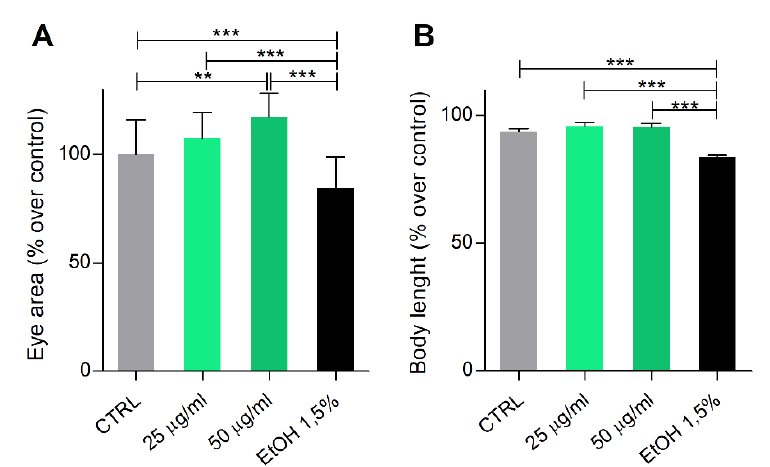
Figure 3. Phormidium EPS treatment has no toxic effects during zebrafish development. Zebrafish embryos were treated with EPS from 6 to 96 hpf, following the indication of the fish embryo acute toxicity test (FET) test. Graphs report results obtained with 25 and 50 µg/mL concentrations, relative to the positive effects on: ( A ) the eye’s area at 1 dpf and ( B ) total body length at 4 dpf. Data are shown as the mean ± SD. Statistical analysis was performed using GraphPad Prism 7 (one-way ANOVA followed by Tukey’s multiple comparison test). Statistical significance: ** p ≤ 0.01, *** p < 0.001.